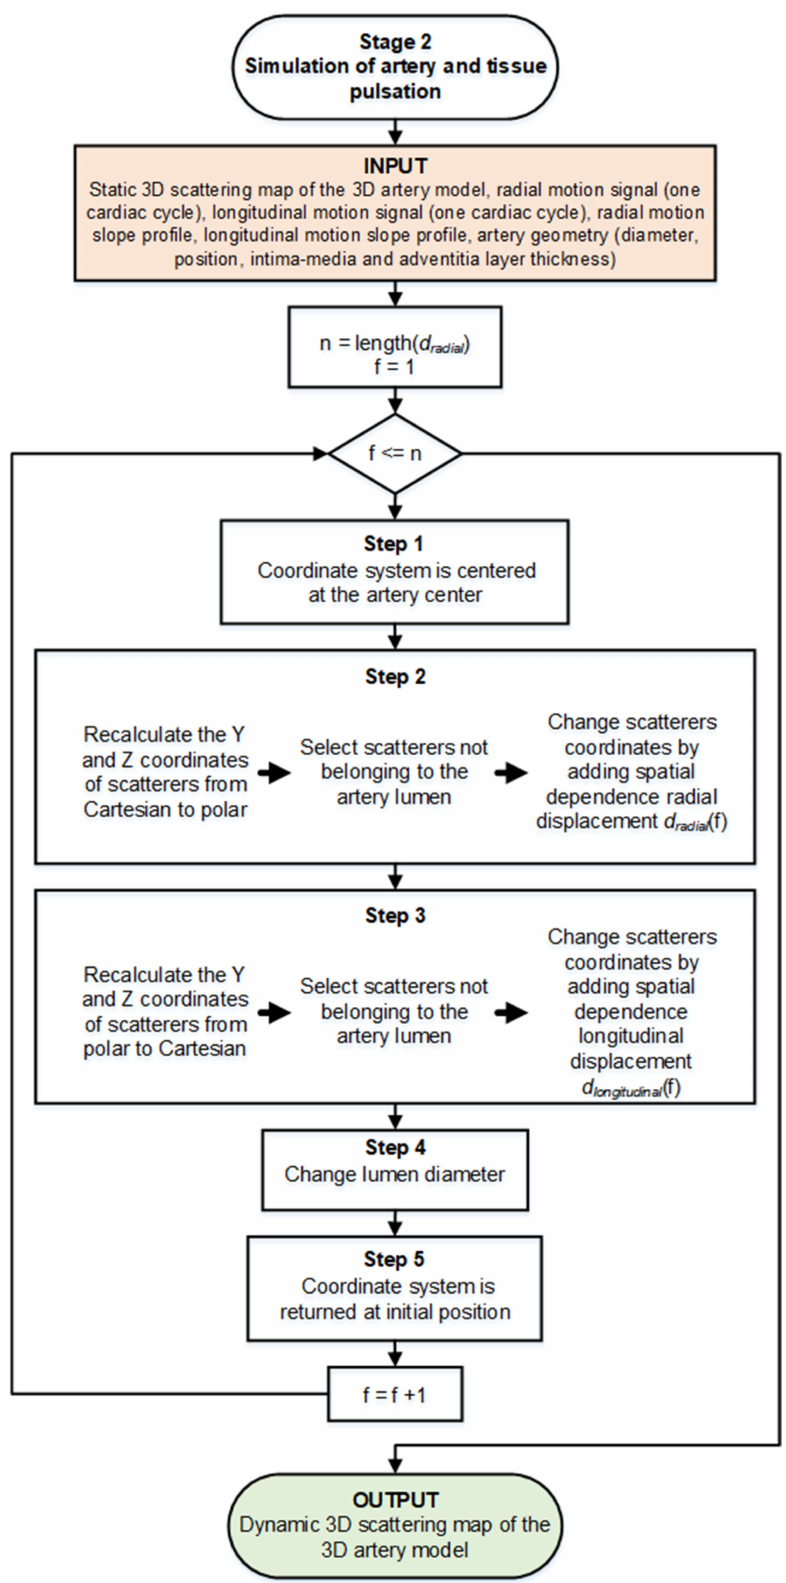
Figure 6. Functional diagram of Stage 2, simulation of the complex artery and tissue pulsation. Here, f corresponds to the currently analyzing frame number in the motion signal, and n corresponds to the total number of such